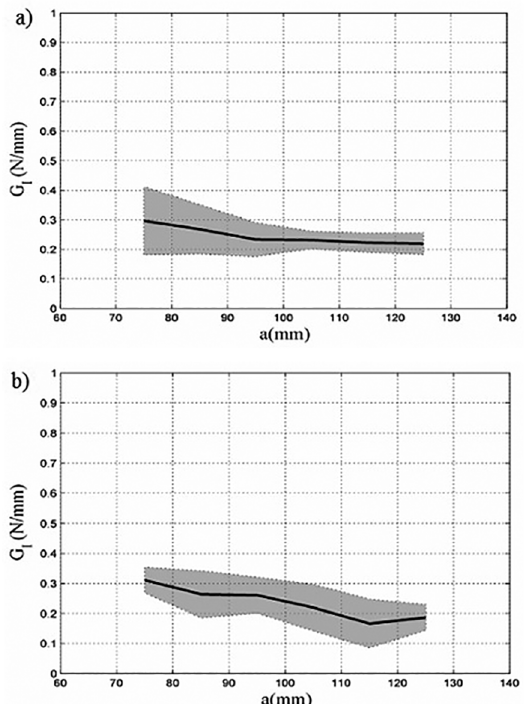
) and propagation (G ) fracture IC Ip